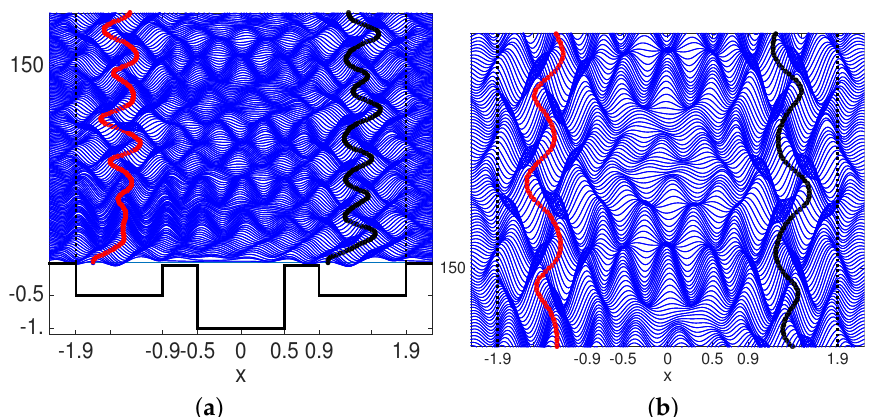
Figure 11. ( a ) On the left, we observe two droplets oscillating within their respective cavities. The deeper mid-cavity acts as an amplifier for waves transmitted over barriers. This enhanced wave-mediated dynamics allow for a stronger interaction between the two droplets. The vertical (droplet position) traces are more complex than those observed in Figure 10. ( b ) On the right graph we observe the detail of the wave-field pattern, which is more intense than that from the case in Figure 10. The mid-cavity-amplifier has enhanced the wave-mediated communication between